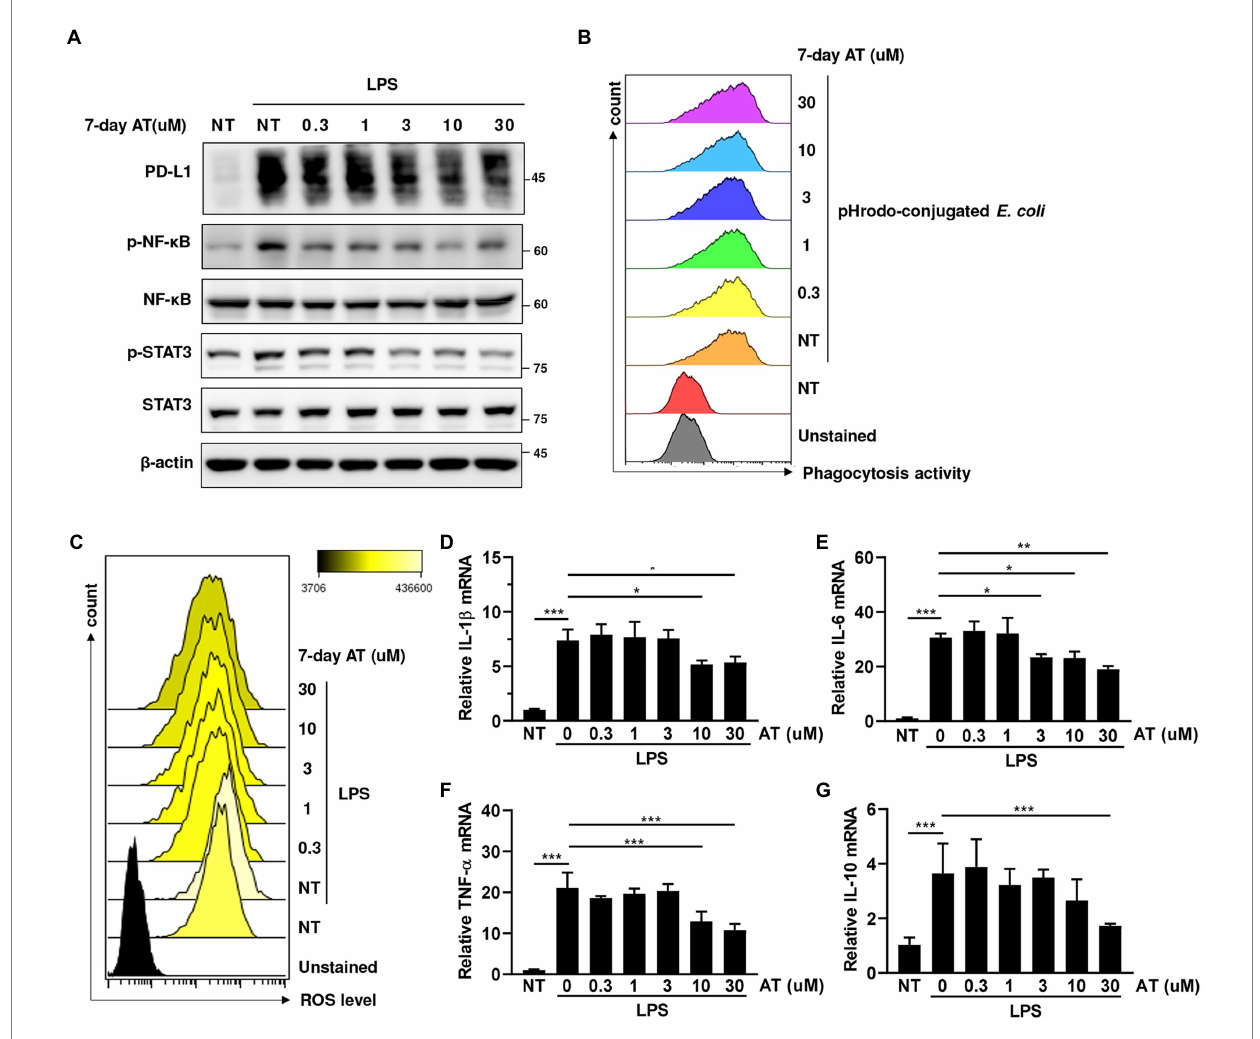
FIGURE 3 Effects of atenolol on the functions of LPS-induced monocyte/macrophages in THP-1 cells. (A) THP-1 cells were pretreated with indicated doses of atenolol for 7 days, and then stimulated with 100 ng/mL LPS overnight. The effect of atenolol on the level of PD-L1 and the activation of NF- κ B and STAT3 were detected by immunoblotting. (B) Atenolol pretreated THP-1 cells were cocultured with pHrodo-conjugated E. coli , and then the phagocytosis activity was analyzed by flow cytometry. (C–G) Following the same treatment as (A) , ROS production was detected by flow cytometry (C) and the expression of inflammatory-related cytokine IL-1 β , IL-6, TNF- α , and IL-10 was detected by RT-qPCR (D–G) . * , p <0.05; ** , p <0.01; *** , p